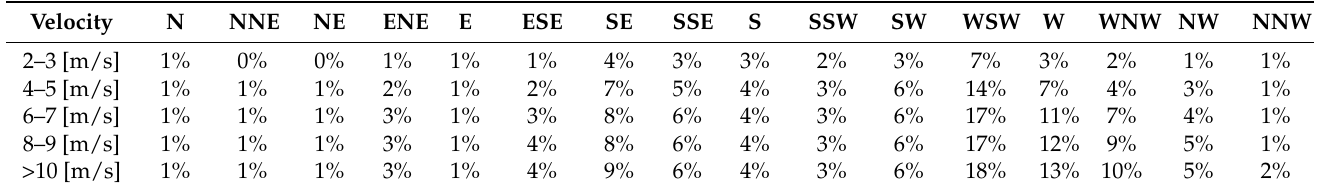
Table 2. The frequency of wind occurrence distributed over cardinal directions for the winter months in 2016–2019. Velocity